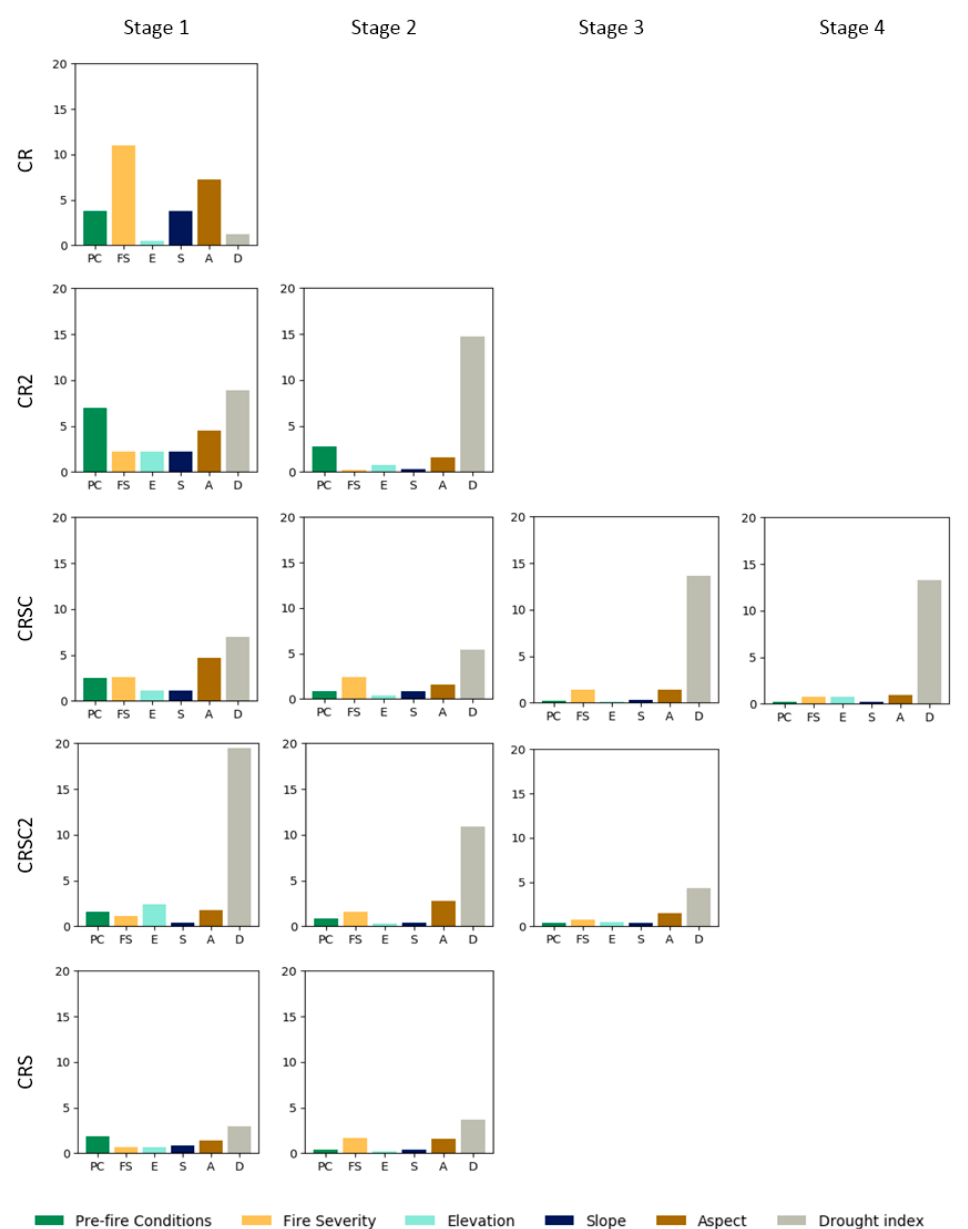
Figure 9. Relative importance of explanatory variables in TCW regression analysis.